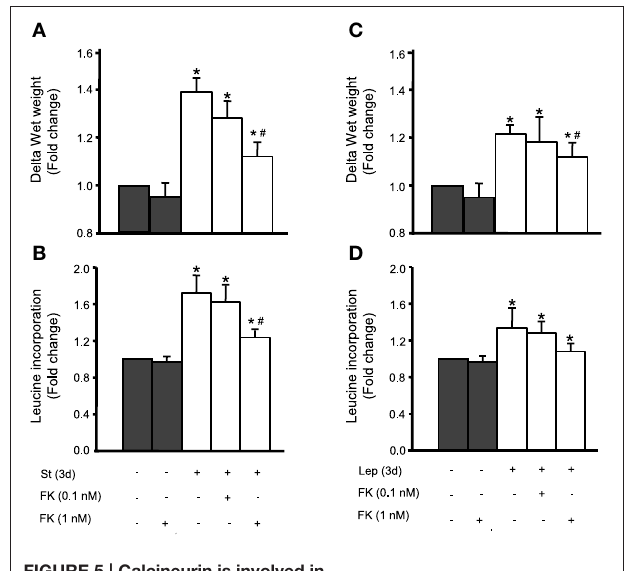
FIGURE 5 | Calcineurin is involved in mechanical stretch/leptin-induced VSMC hypertrophy, assessed by changes in wet weight and protein synthesis by measuring [ 3 H]-leucine incorporation. Mechanical stretch for 3 days significantly increased RPV wet weight (A) and protein synthesis (B) , while pre-treatment with the calcineurin inhibitor FK506 (FK; 0.1 and 1nM) reduced the stretch-induced change in wet weight (A) and protein synthesis (B) ( n = 6–8). * p < 0.05 vs. unstretched. # p < 0.05 vs. St at 3 days. Leptin (3.1nM) treatment alone significantly increased wet weight (C) and protein synthesis (D) while FK506 (0.1 and 1nM) resulted in a reduction in hypertrophy as evaluated by wet weight changes (C) and protein synthesis (D) ( n = 6–8). * p < 0.05 vs. untreated. # p < 0.05 vs. Lep at 3 days.